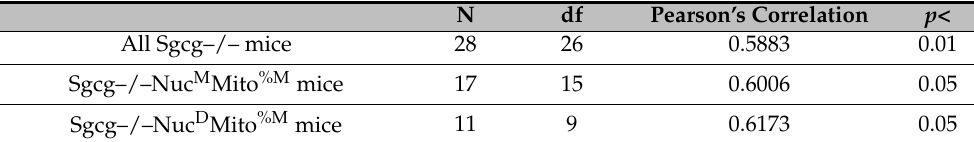
Table 1. Correlation of pAMPK and the percentage of cytosines. N df Pearson’s Correlation p < 28 26 0.5883 0.01 Sgcg–/–Nuc M Mito %M mice 17 0.6006 0.05 0.05